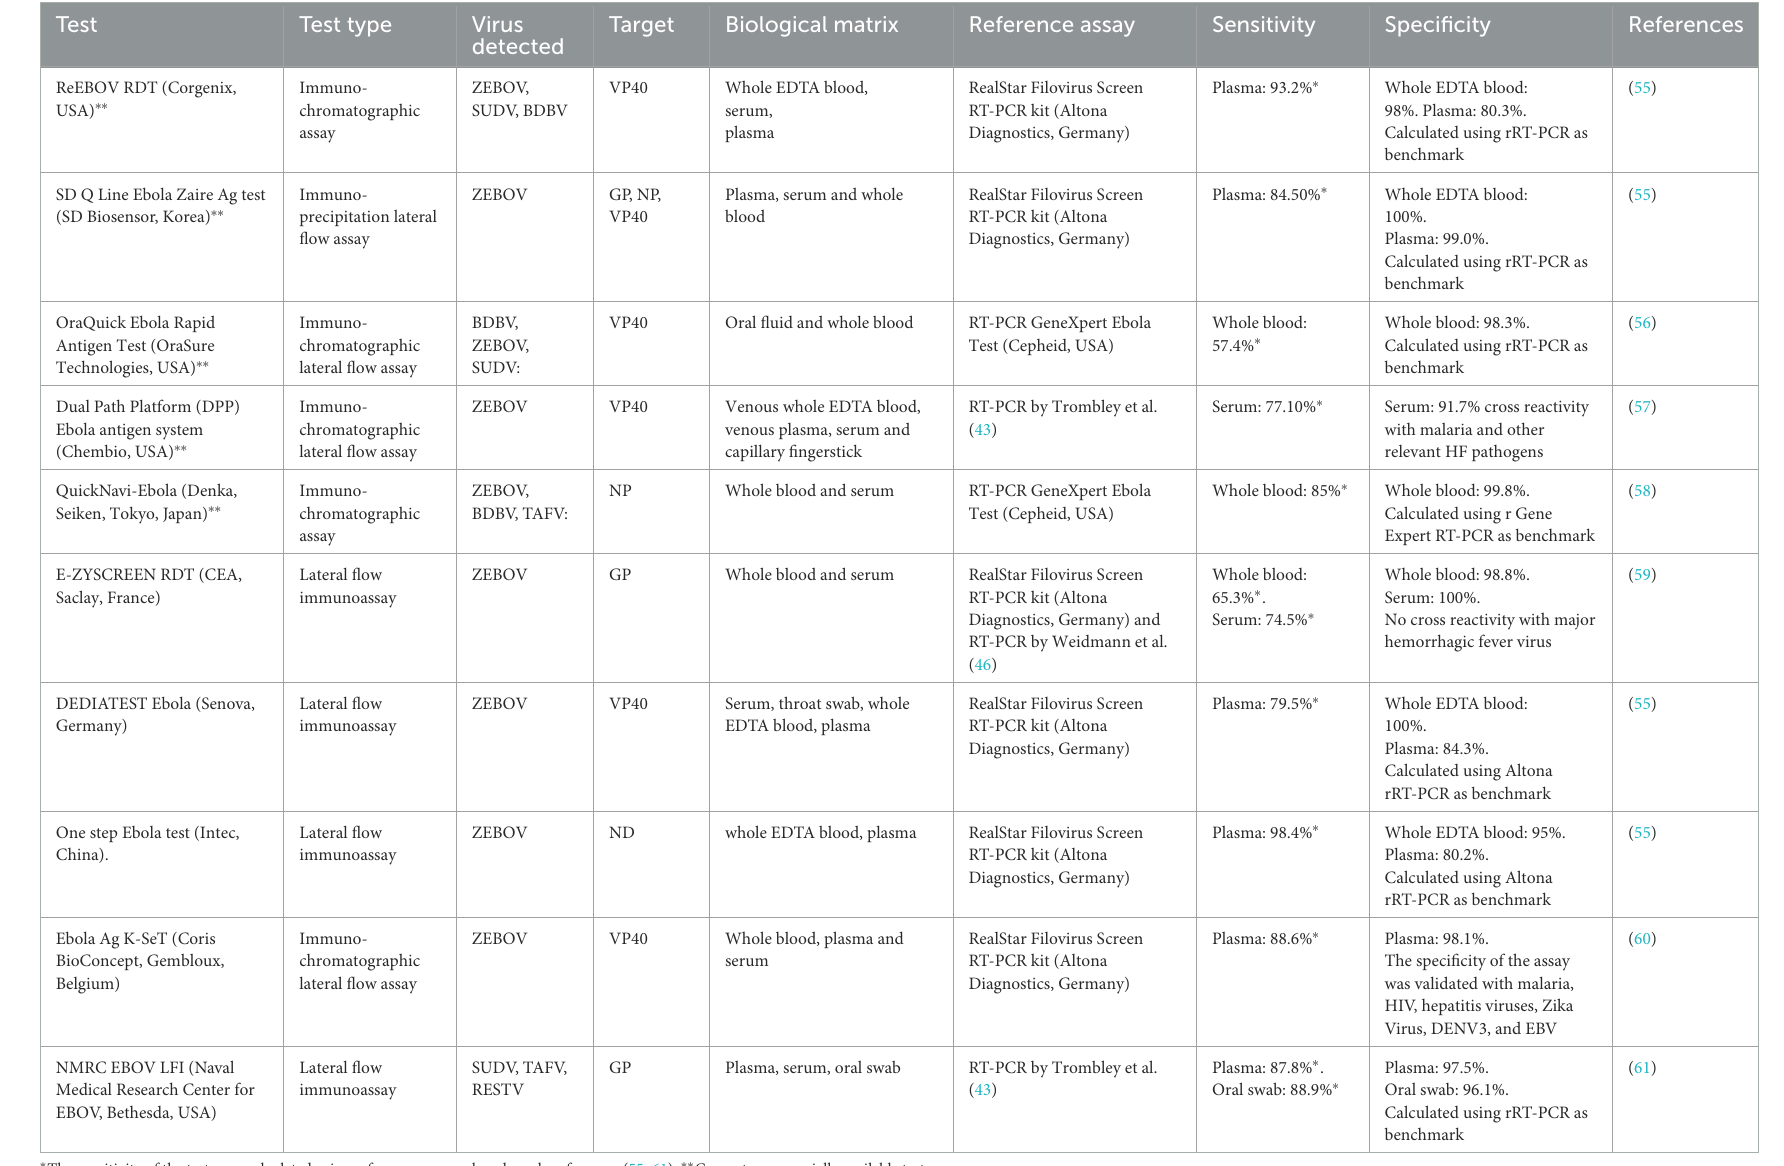
TABLE 2 Rapid diagnostic test for Ebola